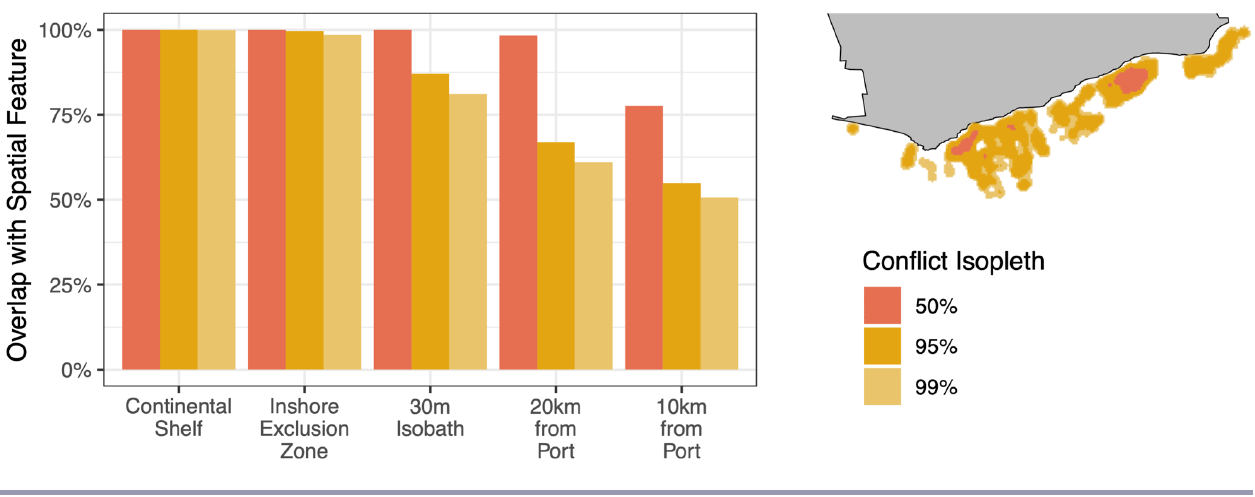
Fig. 2. The association of conflict between small-scale and industrial fishers with spatial features of interest (continental shelf, Inshore Exclusion Zone (IEZ), 30-m isobath, and port proximity) off the coast of Ghana. The overlap value on the y-axis corresponds to the percentage of each predicted conflict isopleth (50%, 95%, and 99%) that falls within the polygon associated with each spatial feature. Isopleths are spatial polygons that represent the smallest area containing a given percentage of all probable conflict locations, as determined through weighted kernel density estimation. The inset map illustrates the spatial distribution of the 50%, 95%, and 99% conflict isopleths along the coast of Ghana (land shown in